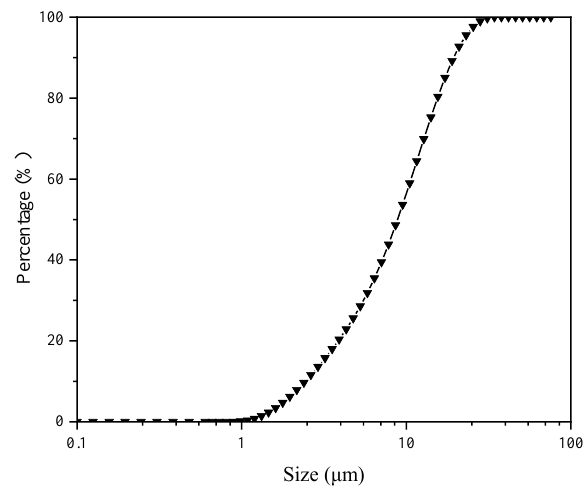
Figure 2. Particle size analysis of LRC sample.